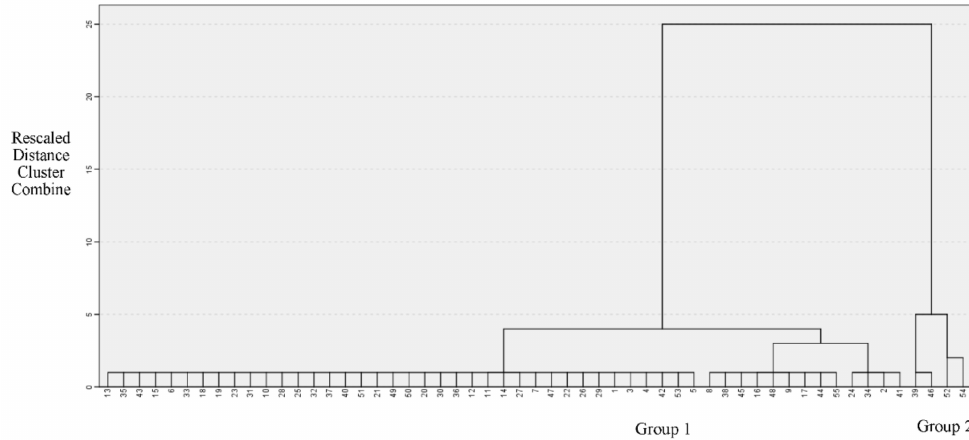
Figure 3. Dendrogram derived from the hierarchical cluster analysis of black carbon (BC) content from 55 soil